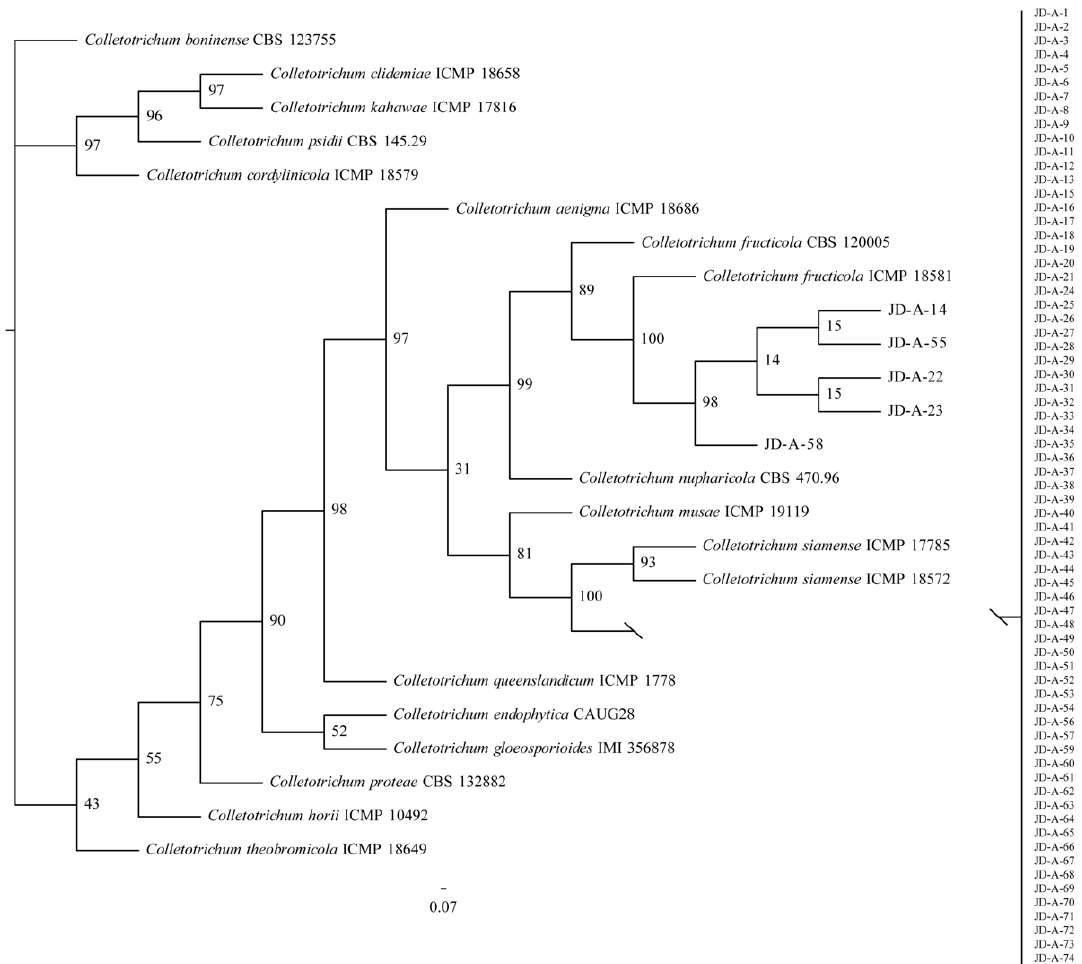
Figure 2. Bayesian inference phylogenetic tree of Colletotrichum gloeosporioides species complex